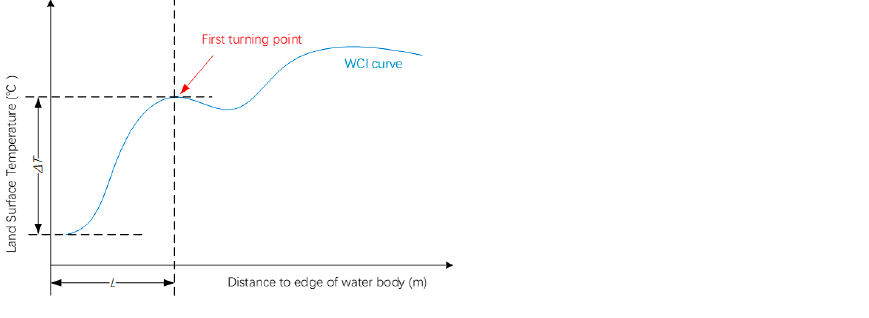
Figure 2. WCI quantification curve: vertical axel indicates land surface temperature; longitudinal axel indicates the distance from the edge of the water body.